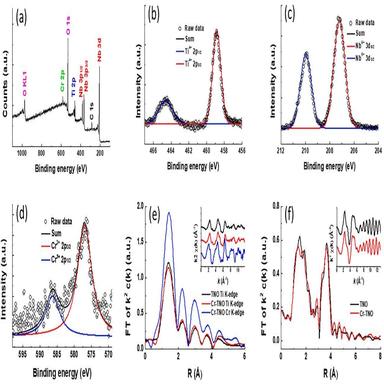
Spectroscopic analysis of TNO and doped TNO. (a) XPS survey of Cr-TNO. (b) Ti 2p, (c) Nb 3d, and (d) Cr 2p XPS spectra of Cr-TNO. (e) Ti and Cr K-edge EXAFS spectra of TNO and Cr-TNO in R-space (inset: corresponding EXAFS spectra in k-space). (f) Nb K-edge EXAFS spectra of TNO and Cr-TNO in R-space (inset: corresponding EXAFS spectra in k-space).